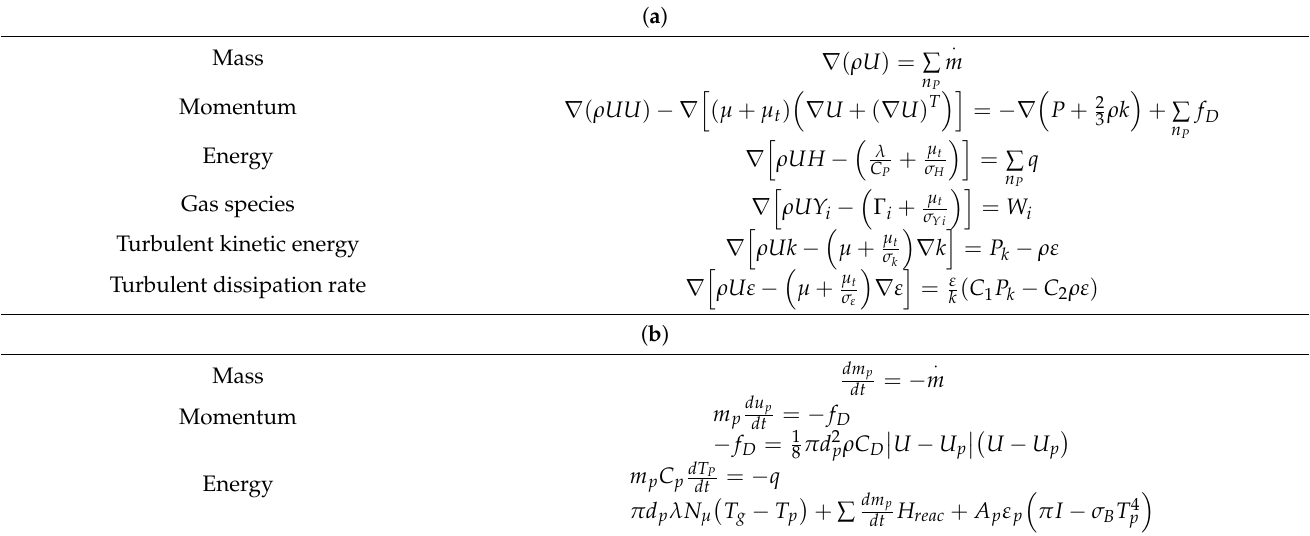
Table 3. Governing equations: ( a ) governing equations for the gas phase; and ( b ) governing equations for the particle phase.